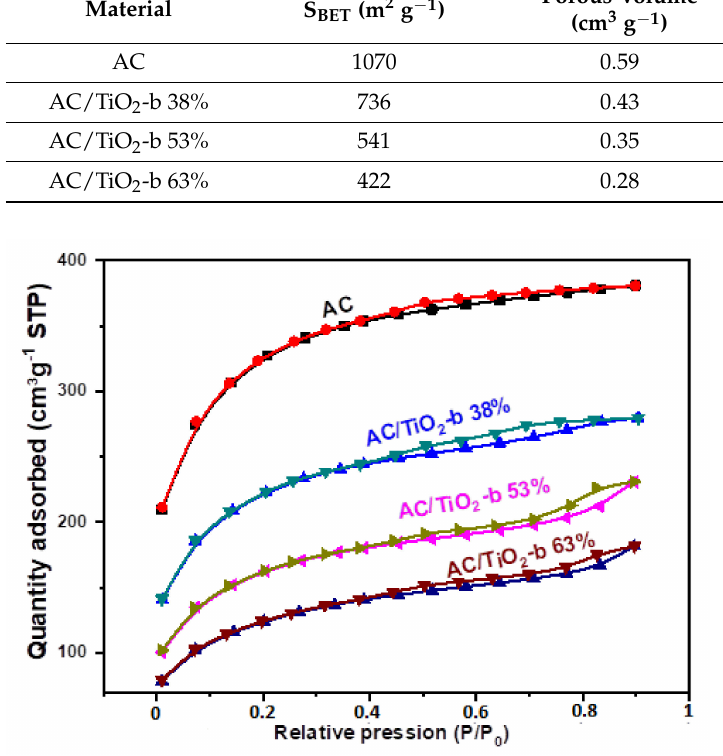
Figure 5. N 2 adsorption/desorption isotherms of AC and AC/TiO 2